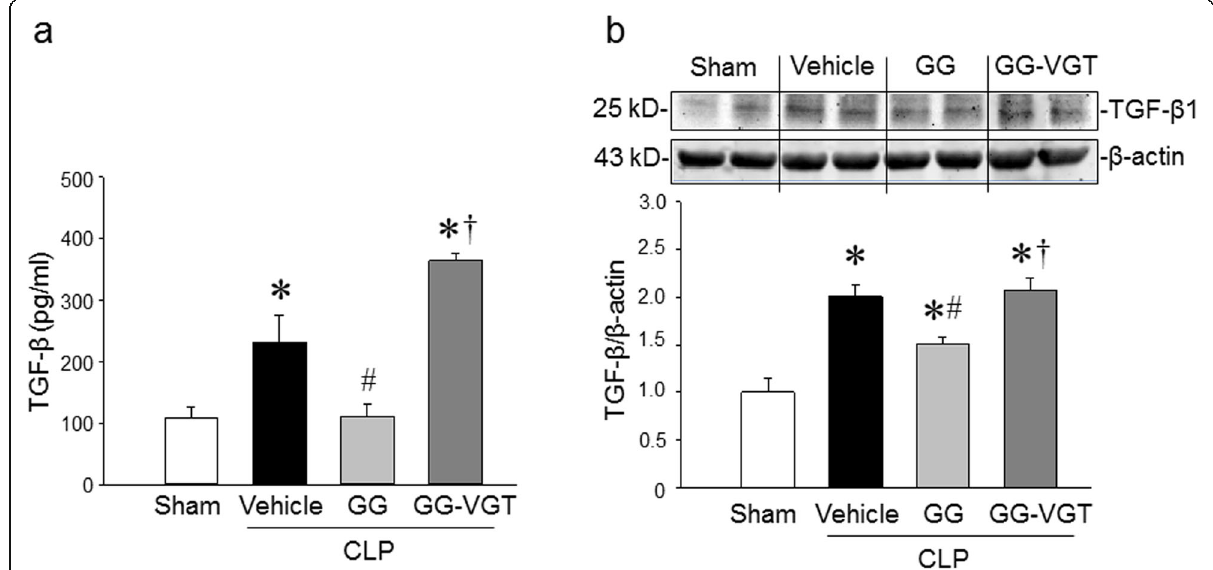
Fig. 1 Ghrelin and GH in combination downregulates TGF- β in aged rats with sepsis. Rats were subjected to sham or CLP operation and treated with vehicle (normal saline) or GG (ghrelin 80 nmol/kg, GH 50 μ g/kg) at 5 h after CLP. In an additional group of rats, vagotomy was performed at the time of CLP and treated with GG at 5 h after CLP. Serum and spleens were collected at 20 h after CLP. a The levels of TGF- β in the serum was measured by ELISA. Data are expressed as mean ± SEM ( n = 4 – 7 rats/group). b The expression of TGF- β in the spleen were determined by western blotting. The representative western blot images are shown. Sham was normalized as 1 in western blot analysis. Data are expressed as mean ± SEM ( n = 4 – 5 rats/group). * P < 0.05 vs. sham; # P < 0.05 vs. CLP with vehicle treatment; † P < 0.05 vs. CLP with GG treatment. CLP, cecal ligation and puncture; GG, ghrelin and growth hormone in combination; VGT,